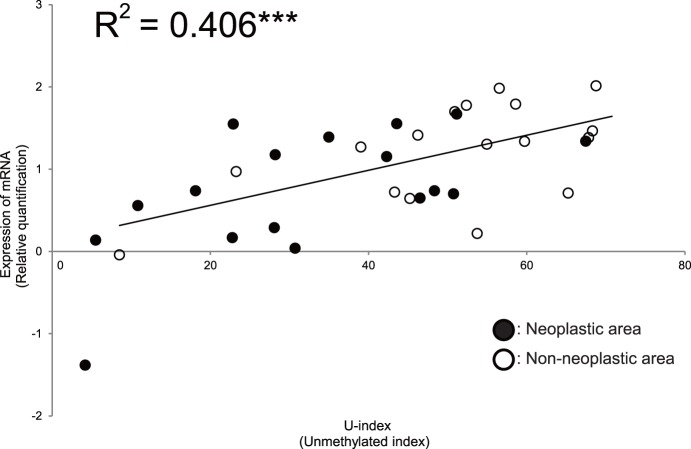
Expression level of MUC1 mRNA and methylation status in pancreatic tissue of PDAC specimens.Correlation analysis of mRNA levels and extent of DNA methylation. The MUC1 U-index showed a strong correlation with the MUC1 mRNA level (R2 = 0.406, P<0.001). Relative mRNA expression was calculated based on the expression level of MUC1 in a human pancreatic cell line (Panc1). The U methylation index (U-index) was normalized using a cell line (LS-174T) with low methylation.